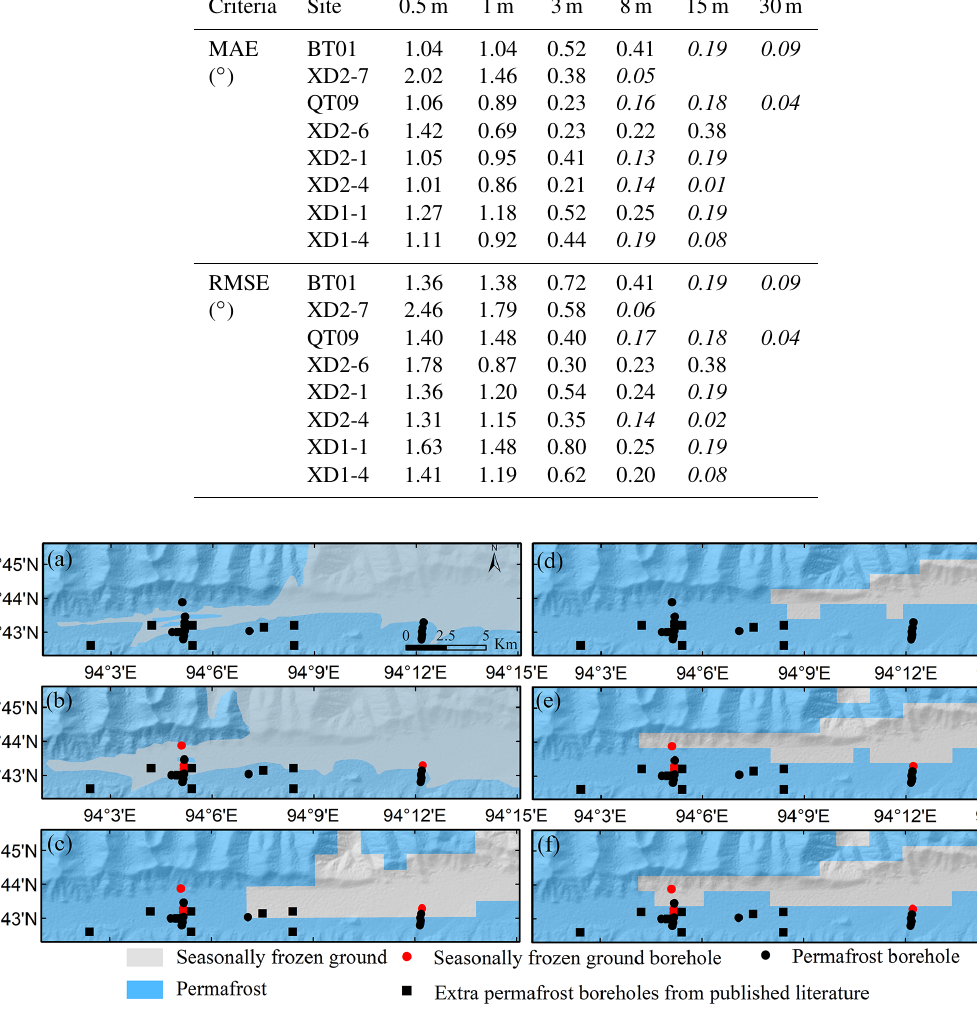
Figure 2. Geographic distribution of permafrost and seasonally frozen ground across Xidatan for three permafrost maps in 1975, 2012, and 2016 (left panels: 1975 a , 2012, b , 2016 c , published in Nan et al., 2003; Luo et al., 2018; Zou et al., 2017) compared to corresponding modeled outputs (right panels: 1975 d , 2012 e , 2016 f